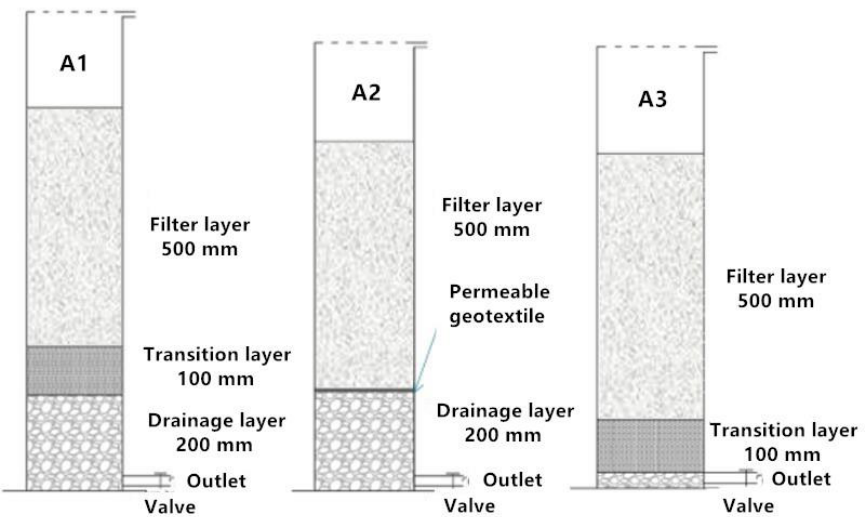
Figure 1. Schematic of bioretention units for hydrologic performance experiments.